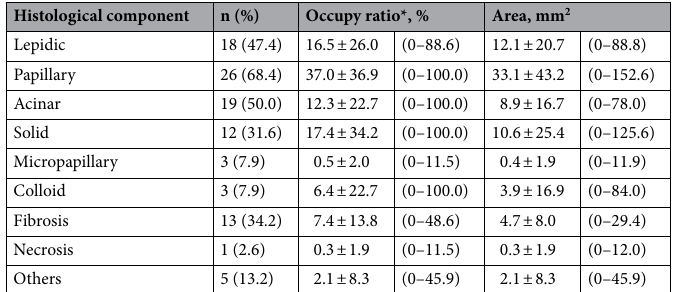
Table 2. Histological features of each histological component. *The ratio of histological component within the tumor for each of the 38 lesions. Continuous variables are presented as mean ± SD (range).